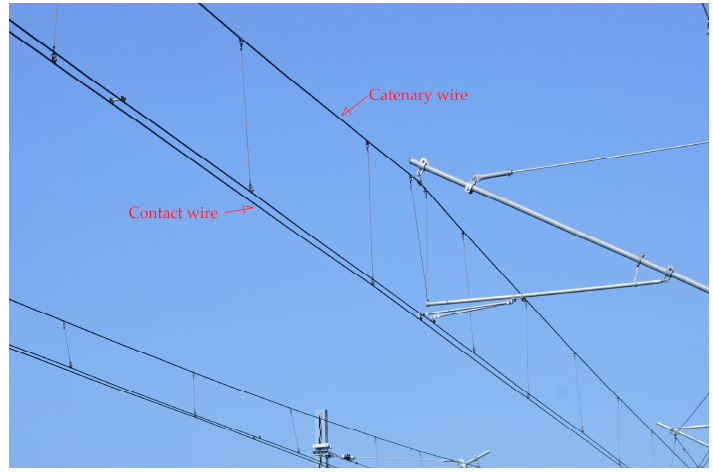
Figure 2. Catenary cables.